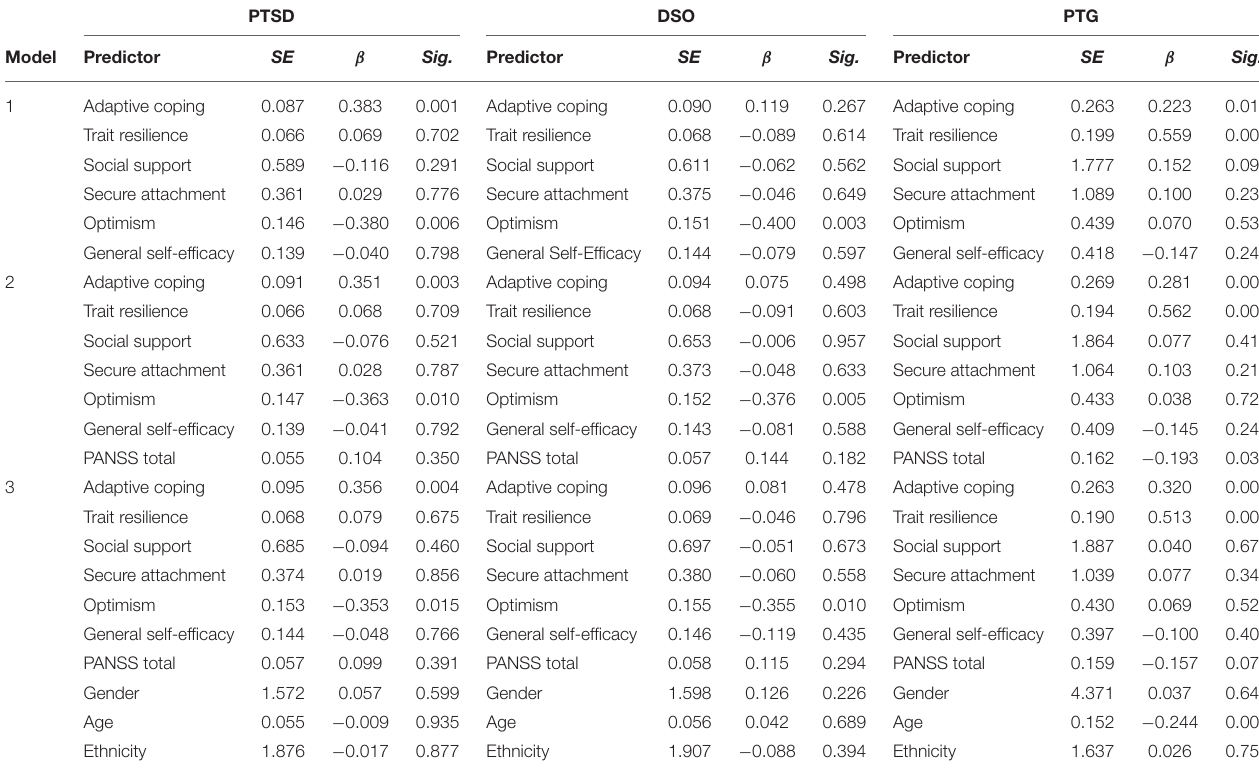
TABLE 3 | Summary of the regression